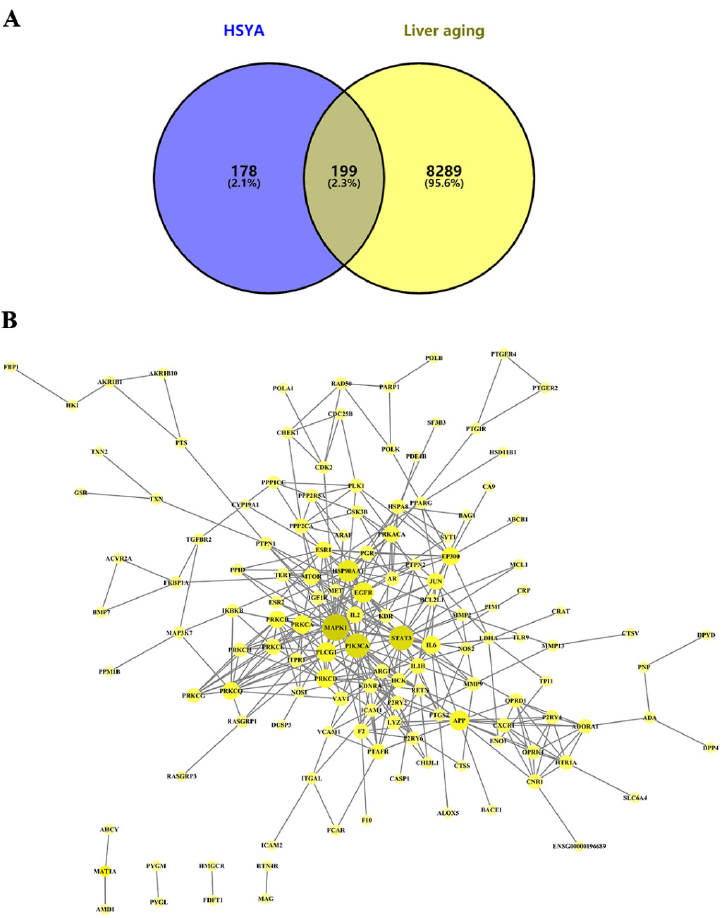
Figure 1. Potential targets of HSYA delay of LA. ( A ) Venn diagram of predicted targets of HSYA and LA. ( B ) PPI network analysis of relevant targets of HSYA delay of LA. Network nodes represent proteins, nodes represent potential proteins, and edges represent protein interactions. The sizes and colors of the circles were set according to the degree value of the node. The higher the degree value, the larger the protein and the darker the color, indicating that the protein could play a more central role. The color and thickness of the edges are positively correlated with the combined score of the proteins; darker colors and thicker edges represent higher importance.